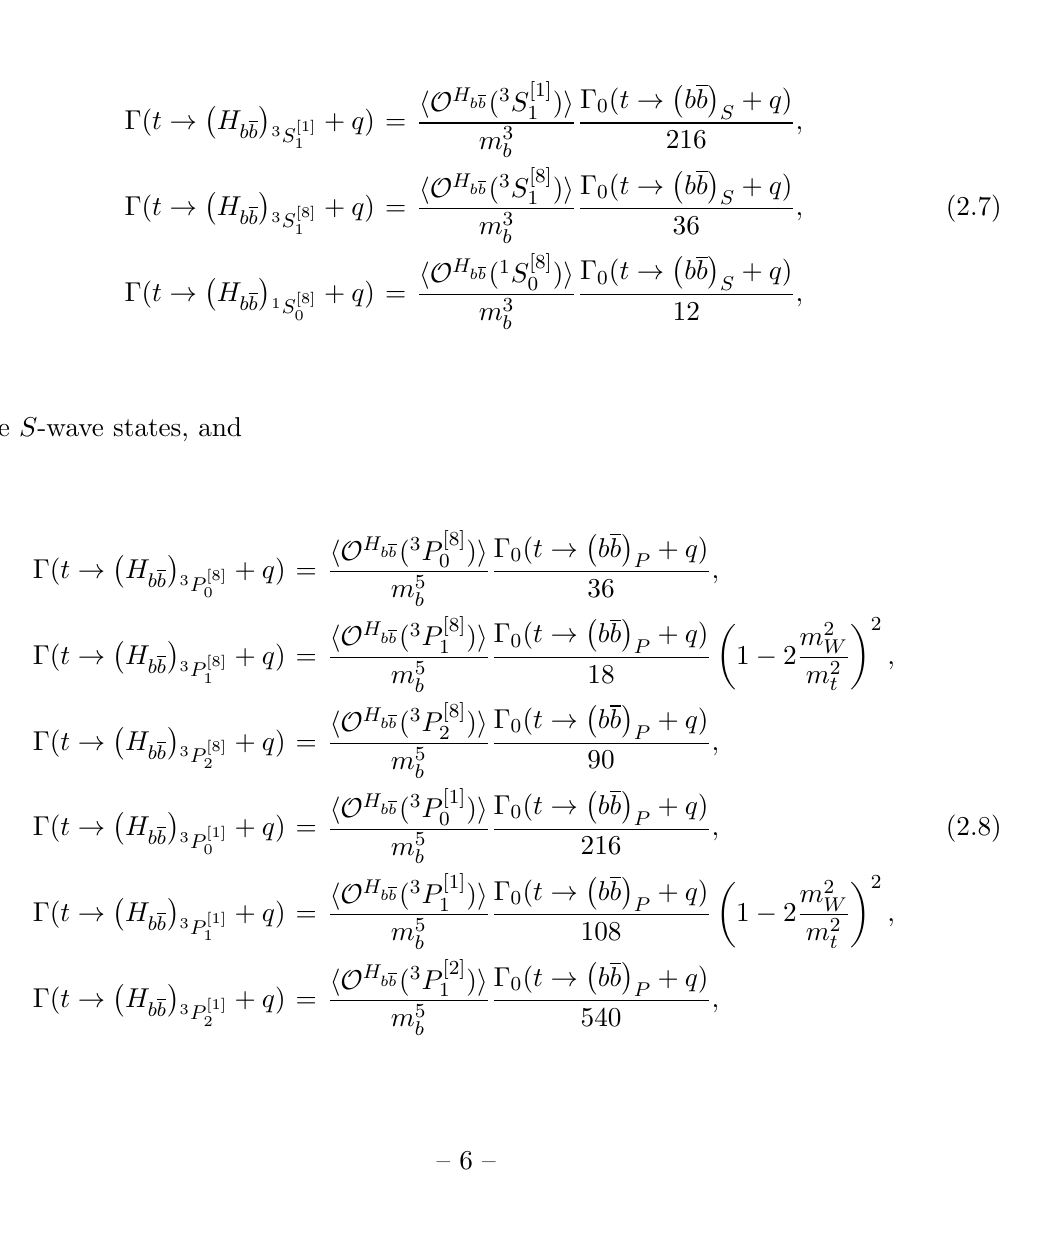
Table 2 . Partial widths and branching fractions of top-quark two-body decays into a B 0 plus a jet, computed here. The branching fractions assume a total top width of (cid:0) t = 1 : 35 GeV [1]. (Theoretical uncertainties, of the order of 100%, not